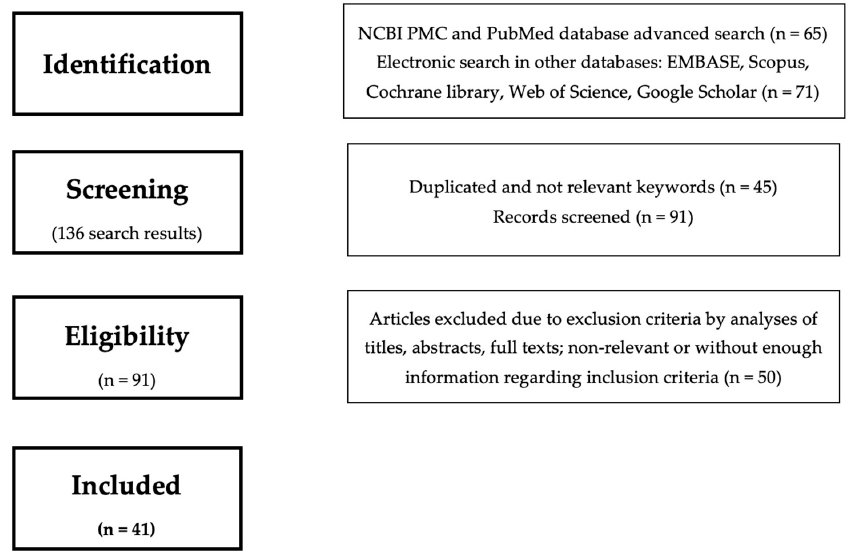
Figure 1. Flow chart illustrating flow information from search strategy to final included studies. Nine studies did not record participants’ gender; in the other studies, there were 727 female participants and 1106 male participants.